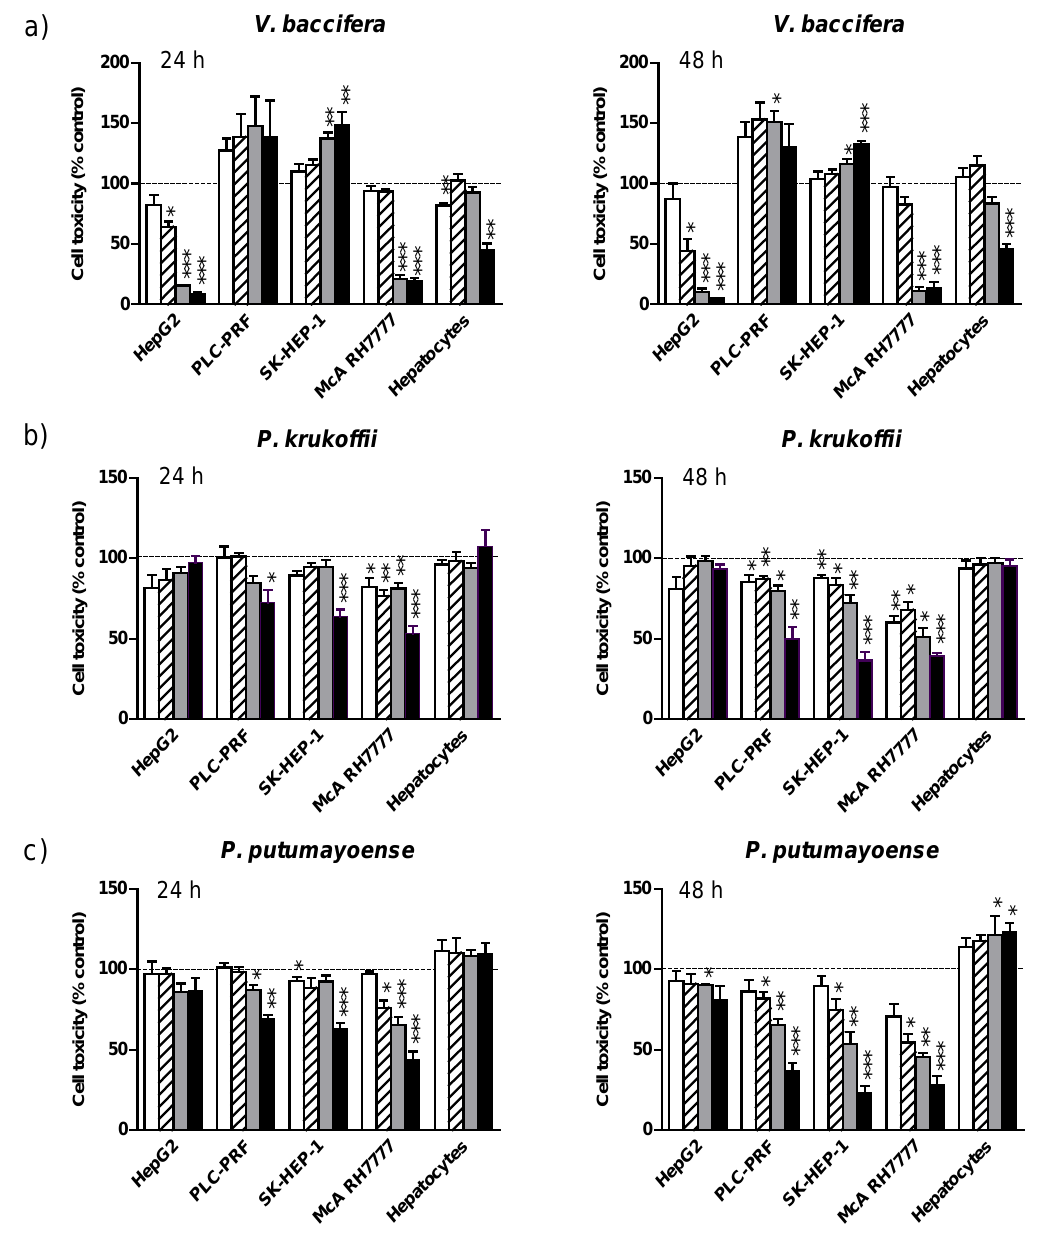
Figure 1. Effects of ( a ) V. baccifera ; ( b ) P. krukoffii ; and ( c ) P. putumayoense leaf